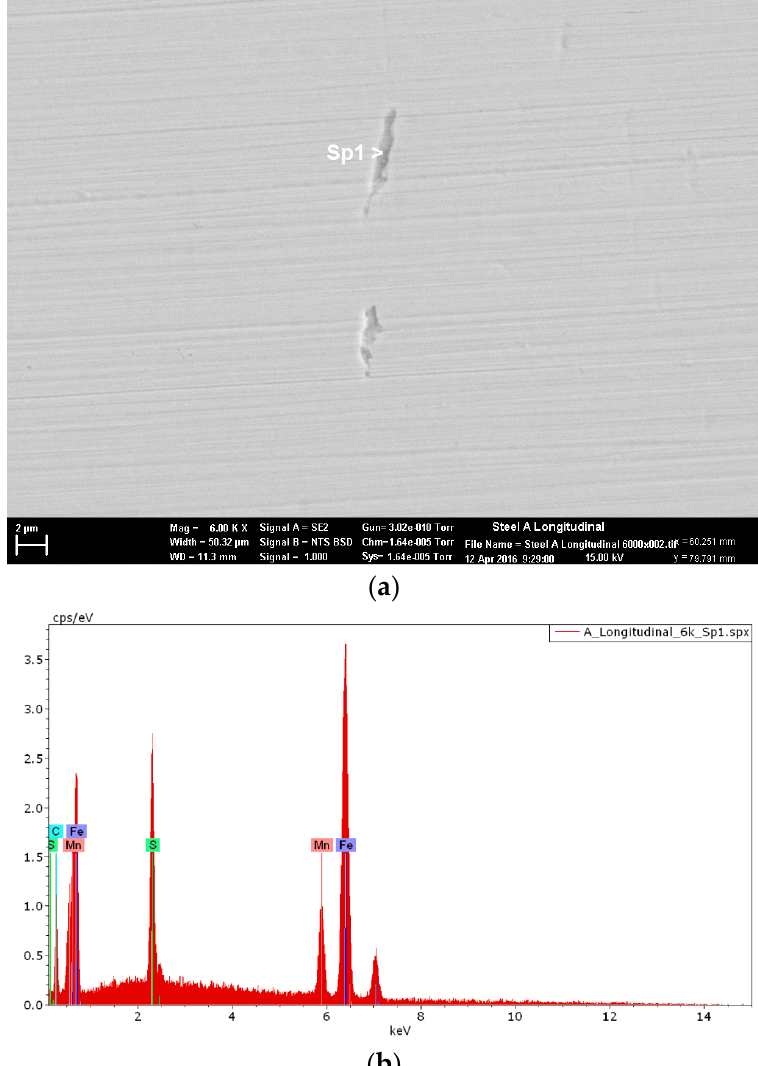
Figure 3. ( a ) SEM image of MnS inclusion on steel A (lowest S content) and ( b ) corresponding EDS spectrum for point Sp1 with peaks